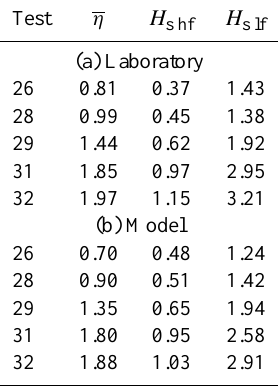
Fig. 5. Free-surface elevation (sea-swell wave: light, thin line; low- frequency wave: dark, thick line) as measured at 22m water depth (LPM3). Table 3. (a) Measured and (b) predicted wave-induced setup ( η ), hf- ( H s hf ) and lf- ( H s lf ) significant wave height at the onshore sensor WG9. Units in cm.